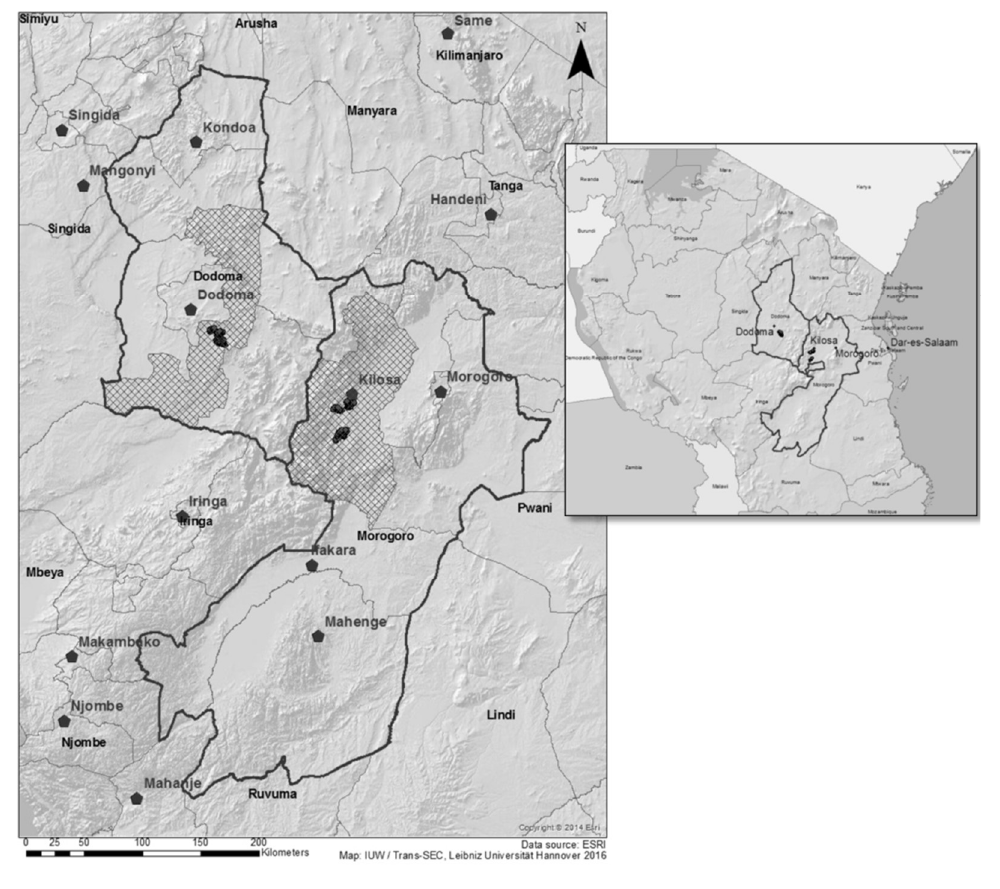
Figure 2. Study sites in Morogoro and Dodoma regions, Tanzania (Source: Trans-Sec [33]).